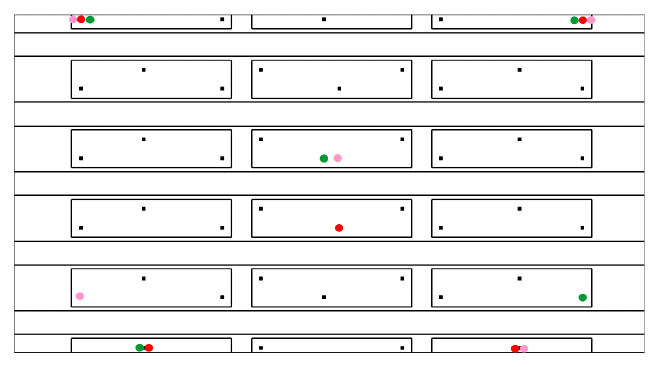
Figure 10. Best five-sensor combinations. Sensors with the same color belong to the same combination.